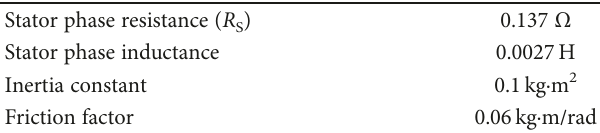
Table 3: PMSG utilized [30].